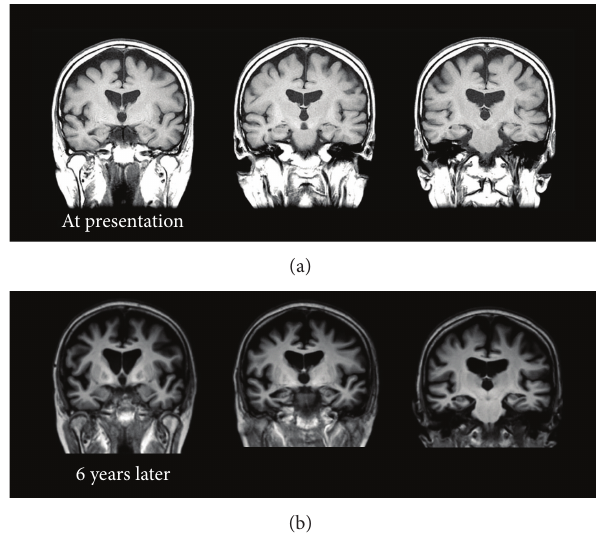
Figure 1: Coronal T1 weighted brain Magnetic Resonance Image (MRI) of the patient in Case A at presentation (a) and 6 years later (b). No remarkable vascular change or mass signs were observed. Diffuse cerebral and hippocampal atrophy, as well as enlargement of the lateral ventricles, which advanced at 6 years, was consistent with comorbid Alzheimer’s disease.